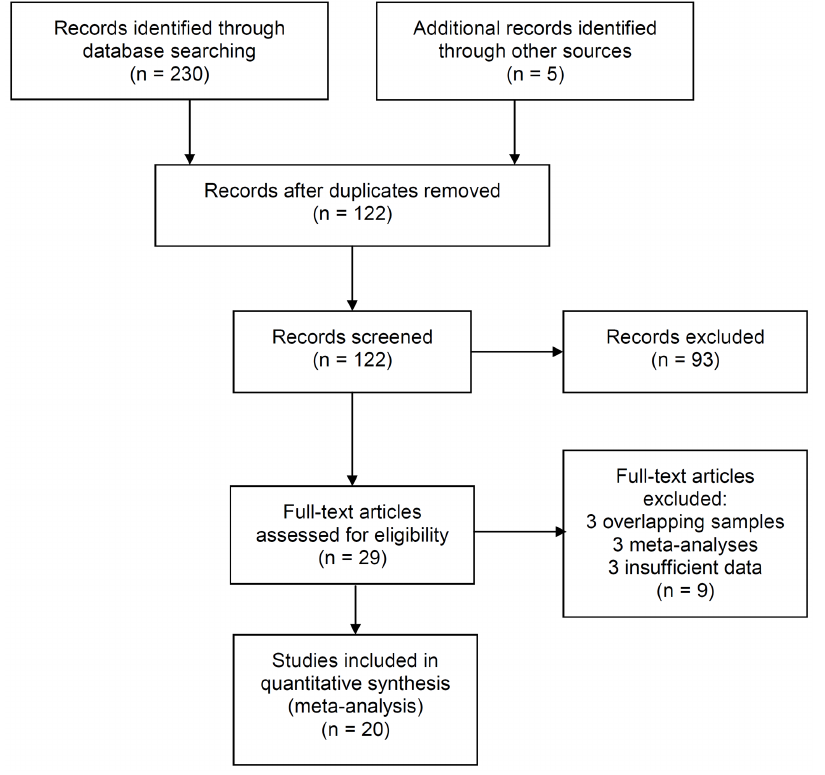
Figure 1. Flowchart of the study selection process.